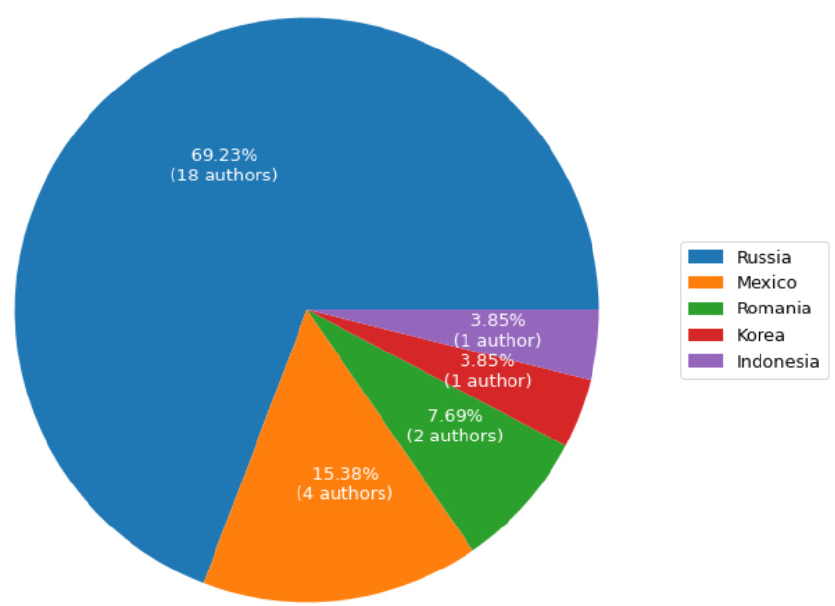
Figure 1. The geographical distribution of the authors of the papers.